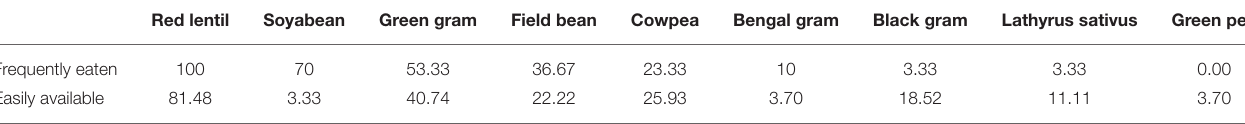
TABLE 9 | Farmer assessment of the frequently consumed and available pulses in non-tribal villages. Red lentil Soyabean Frequently